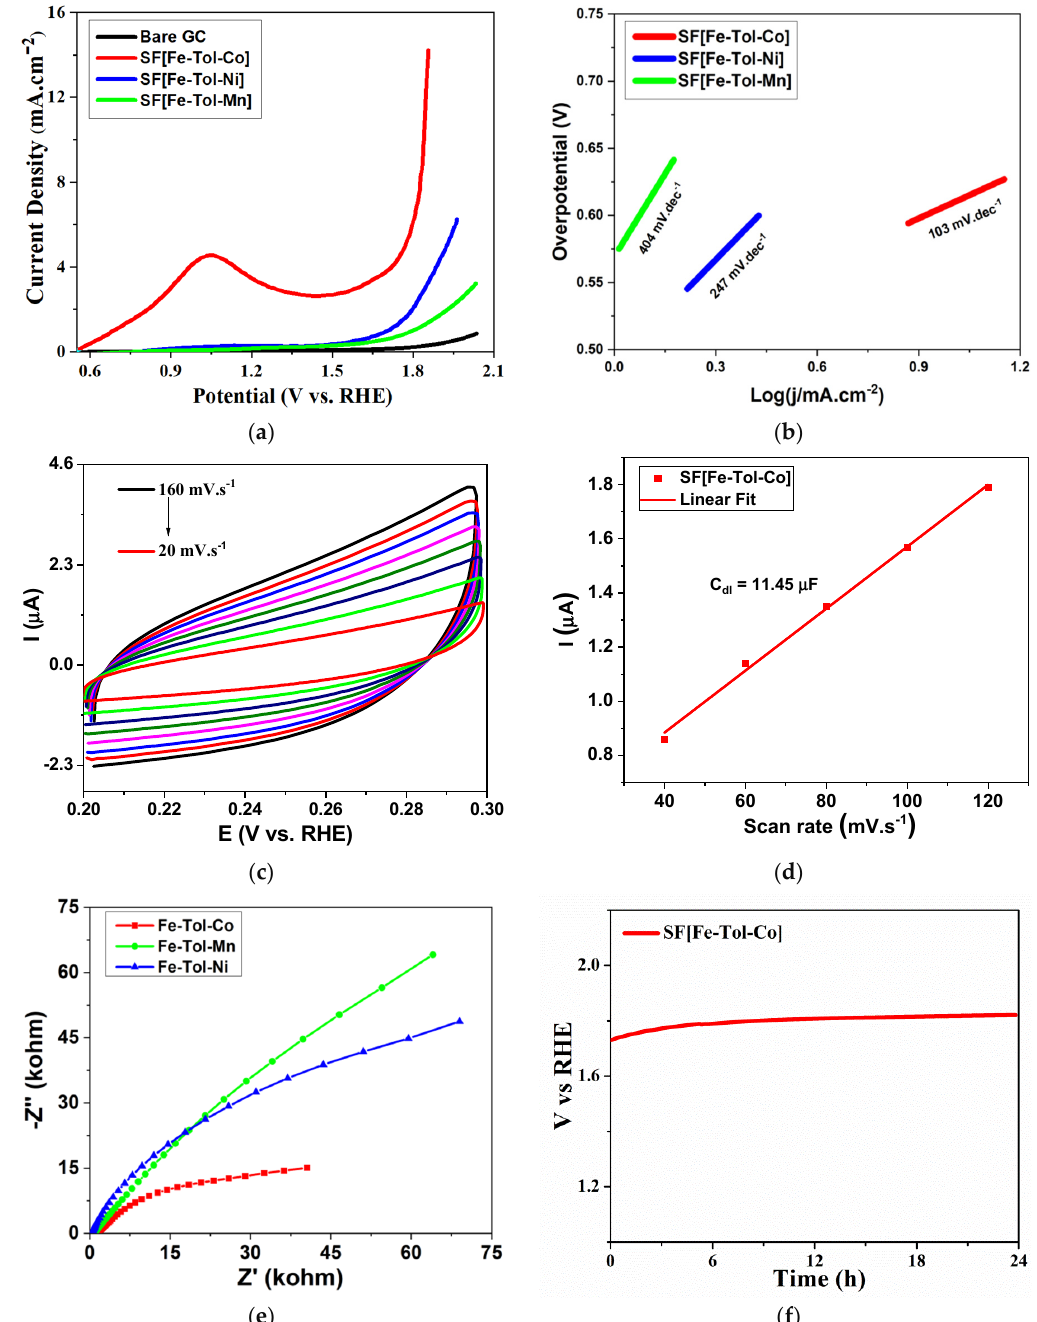
Figure 3. ( a ) Linear sweep voltammograms of bare GCE and SF[Fe-Tol-M], ( b ) Tafel plots of SF[Fe- Tol-M], ( c ) cyclic voltammograms of SF[Fe-Tol-Co] in the non-faradaic potential region at the scan rates ranging from 20 to 160 mV ∙ s − 1 , ( d ) charging currents measured at the potentials 0.25 V vs. Ag/AgCl plotted as a function of scan rates for SF[Fe-Tol-Co], ( e ) Nyquist plots of SF[Fe-Tol-M] in the frequency range from 100 mHz to 100 kHz and ( f ) chronopotentiometric measurement for SF[Fe- Tol-Co] performed to generate constant current density of 5 mV ∙ cm − 2 for 24 h.